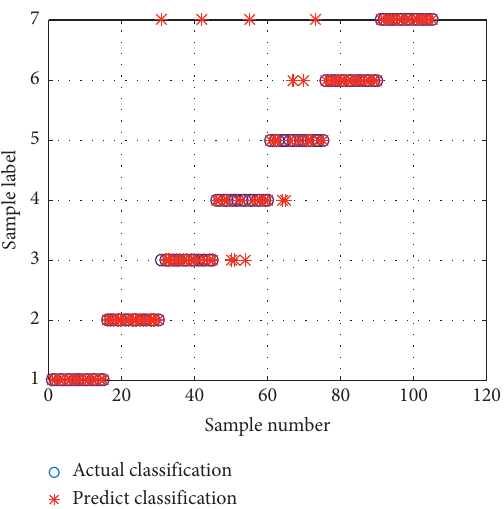
Figure 15: Classification results of IEWT-ELM. Table 8: Fault diagnosis results